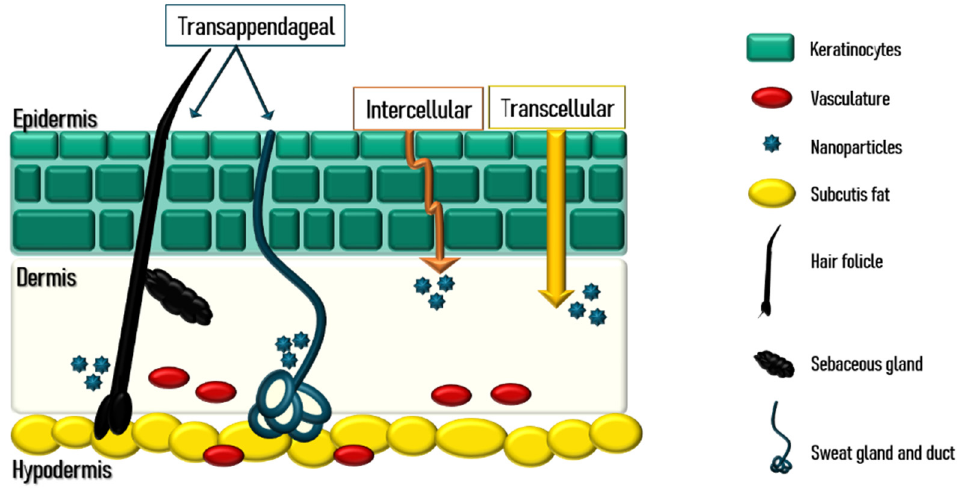
Figure 5. Schematic view of skin layers and drug-delivery routes. Epidermis is the outer skin layer with a thickness variating from 0.05 mm in the thinner areas, such as the eyelids, to 0.8 ± 1.5 mm on the palms of the hands and soles of the feet. It is a stratified epithelium that acts as a physicochemical barrier between the exterior environment and the interior of the body, constituted majorly by: keratinocytes, that produce protein keratins; desmosomes, with ligand properties that connect keratinocytes together; melanocytes, productors of melanin, the pigmentation compound in hair and skin; and Langerhans cells, responsible for the immune response against pathogenic agents.